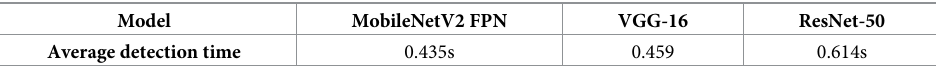
Table 6. Comparison table of average detection time of different network